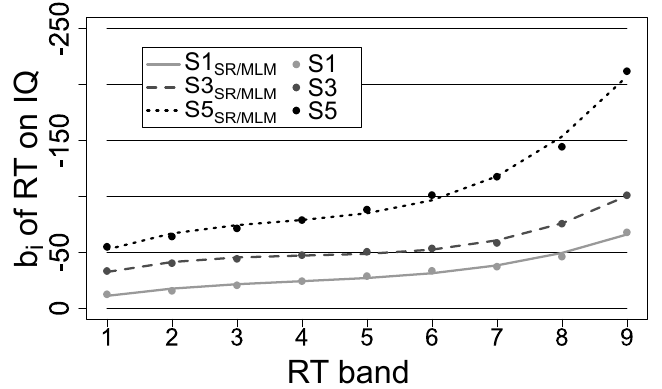
Figure 1. Depicts the prediction of the unstandardized regression weights (dots) across RT bands by the sequential regression and the MLM approach (lines). Note that point estimates for the SR and MLM approach were equal. Thus there were no separate lines for the two